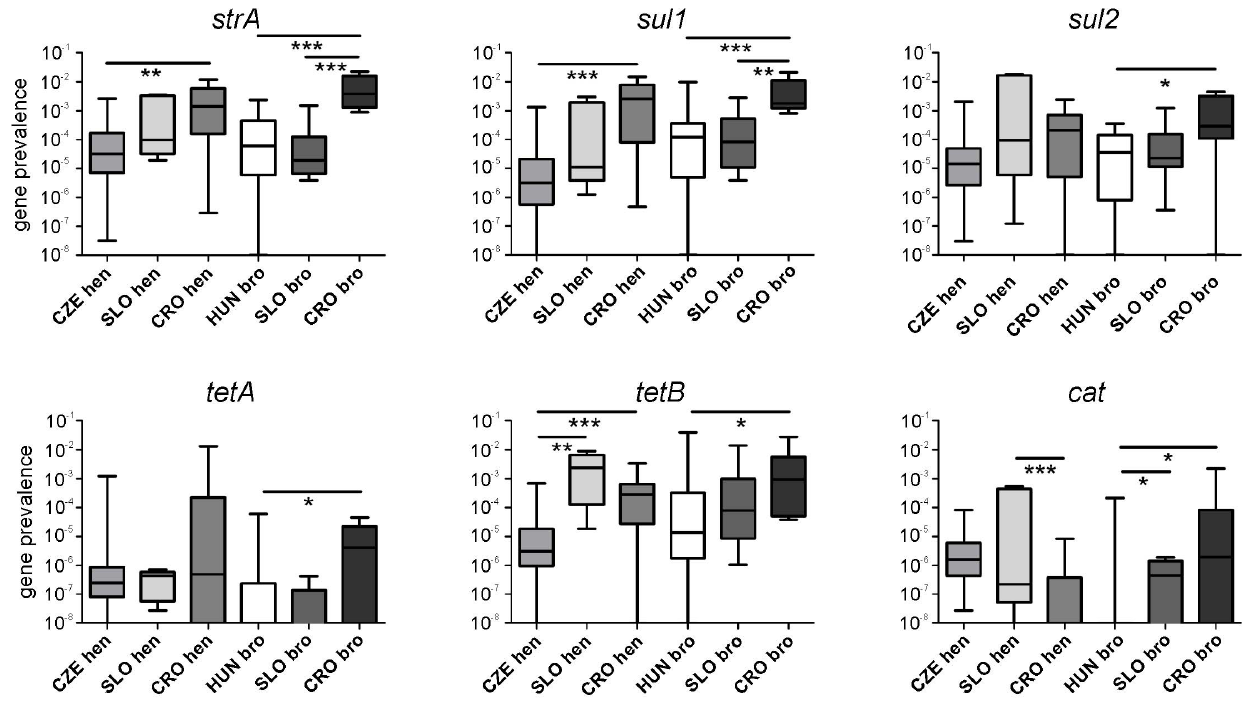
Figure 1. Antibiotic resistance gene prevalence in poultry fecal microbiota. Antibiotic resistance gene prevalence is presented as the median with 25 th and 75 th percentile (box) and the whiskers indicating minimum and maximum values recorded. Mind the logarithmic scaling of Y axis.